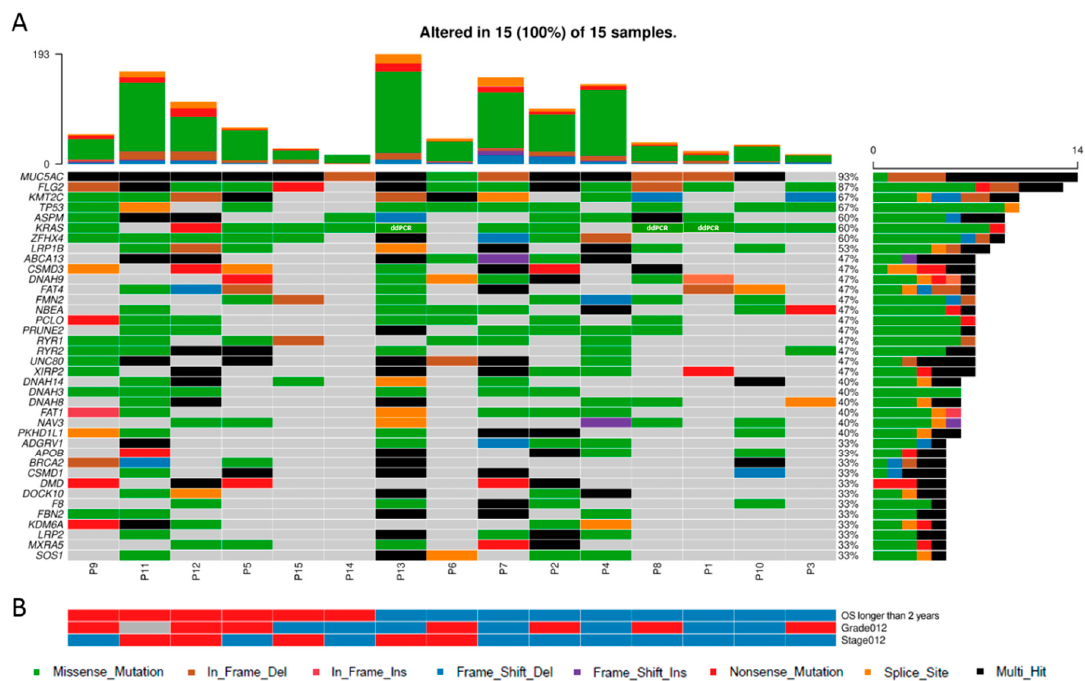
Figure 2. Oncoplot of genes with highest counts of variants in primary tumors. ( A ) Top 50 genes that contain any variant in the highest percentage of the patients displayed. Note that 12 genes were excluded from the analysis because of the presence in the FrequentLy mutAted GeneS (FLAGS) list (Supplementary Table S3). The digital droplet polymerase chain reaction (ddPCR) results are included and highlighted in white letters. ( B ) Clinical features of the patients. Patients were sorted according to the overall survival. Patients surviving longer than two years after diagnosis are depicted in blue color and are placed in the right part of the plot. Patients with shorter survival than two years are depicted in red. Well to moderately di ff erentiated tumors (histologic grade G1 or G2) and tumors with less advanced stage (pathological stage I or IIA) are depicted in blue. Poorly di ff erentiated tumors (grade G3) and tumors with more advanced stage IIB are depicted in red. Histological grade was not available for one sample (depicted in gray).